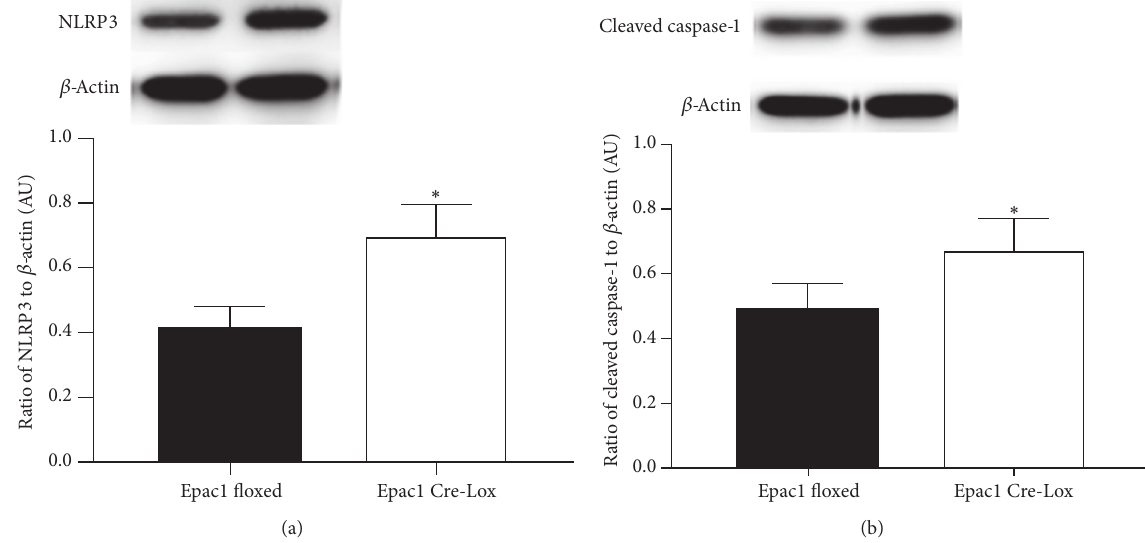
Figure 2: Epac1 reduces formation of the NLRP3 inflammasome and the cleavage of caspase-1. Western blot data from retinal lysates from Epac1 floxed and Epac1 Cre-Lox mice for NLRP3 (a) and cleaved caspase-1 (b). ∗ 𝑃 < 0.05 versus Epac1 floxed. 𝑁 = 6 . Data are mean ±